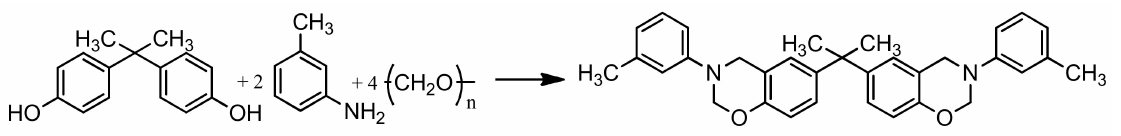
Figure 6. Synthesis of